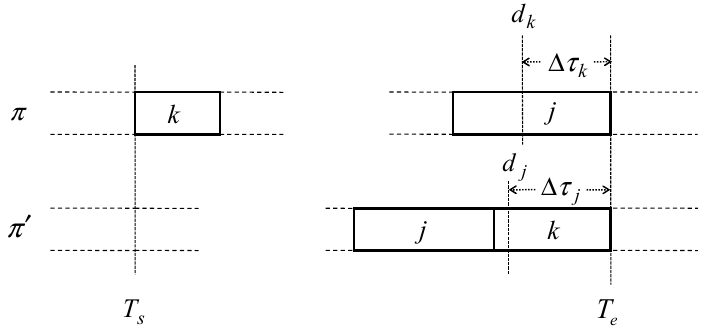
Figure 3. The effect of moving an order after another one in an order sequence Figure 3. The e ff ect of moving an order after another one in an order